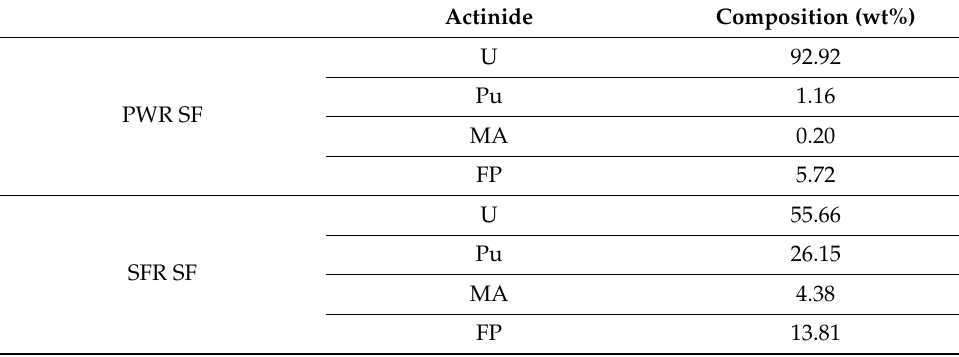
Table 6. Actinide composition of spent fuel.